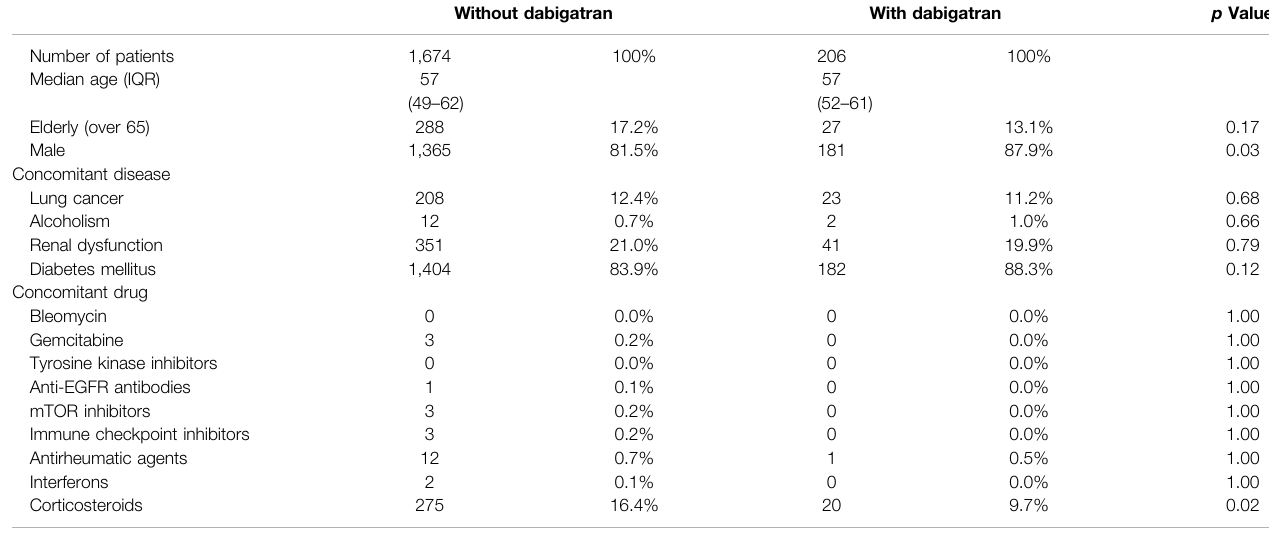
TABLE 1 | Population characteristics of the patients in the amiodarone cohort of JMDC data.